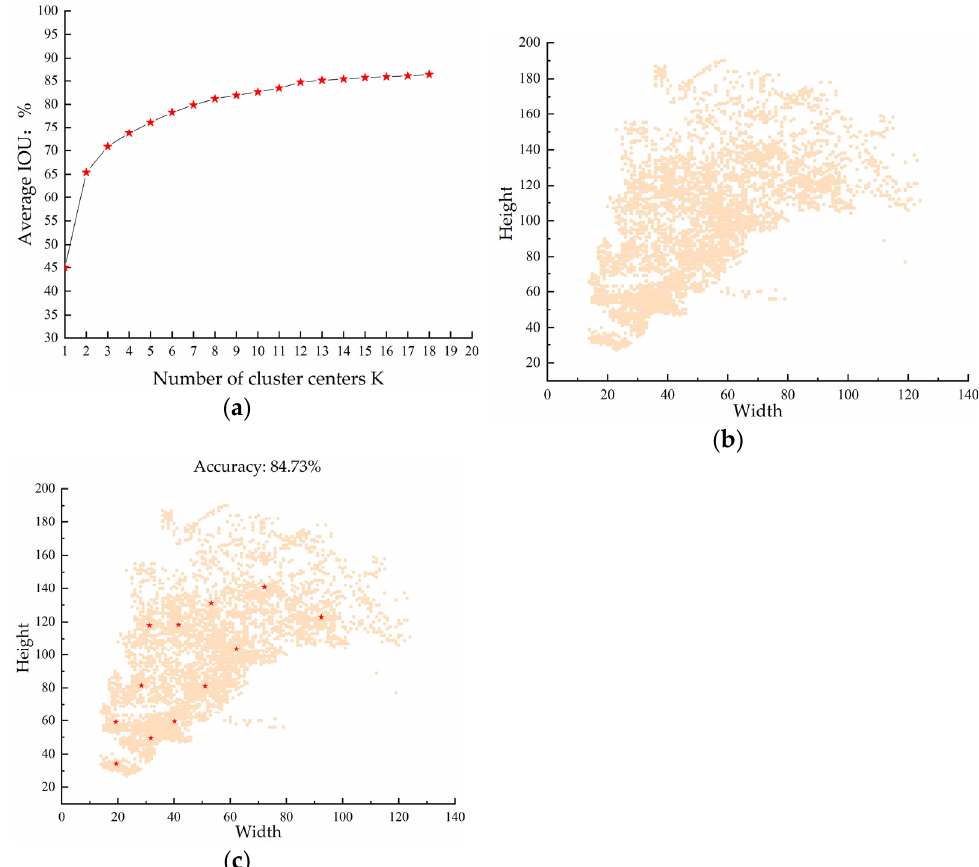
Figure 8. Anchor box re-clustering of datasets: ( a ) The average IOU values corresponding to different K values; ( b ) Distribution of labeled boxes of the dataset; ( c ) Clustering effect of anchor boxes.